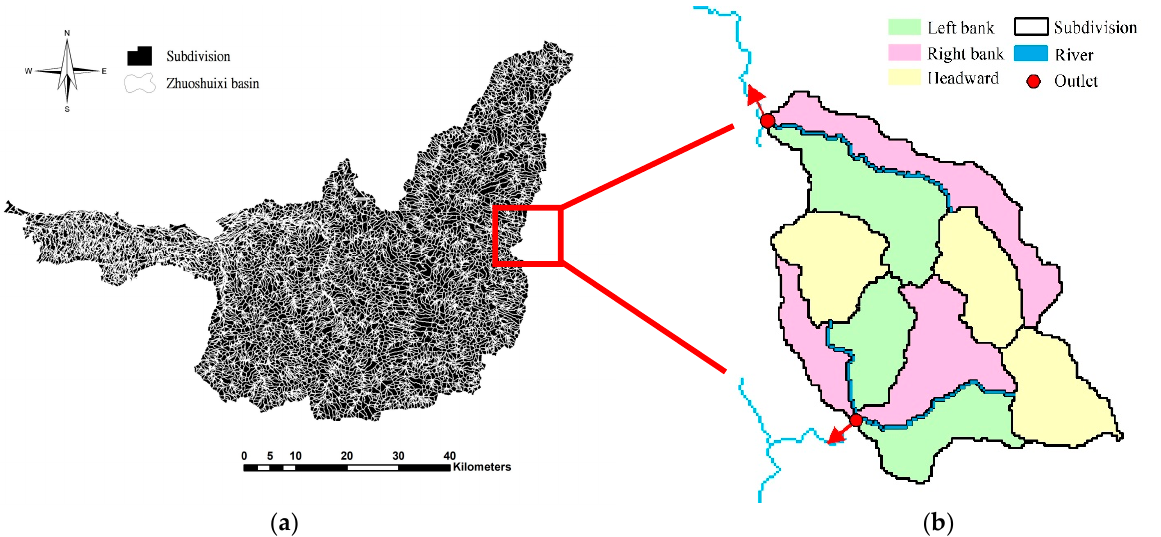
Figure 2. Analysis unit division: ( a ) spatial distribution of the specific watershed and ( b ) subdivision of the specific watershed.